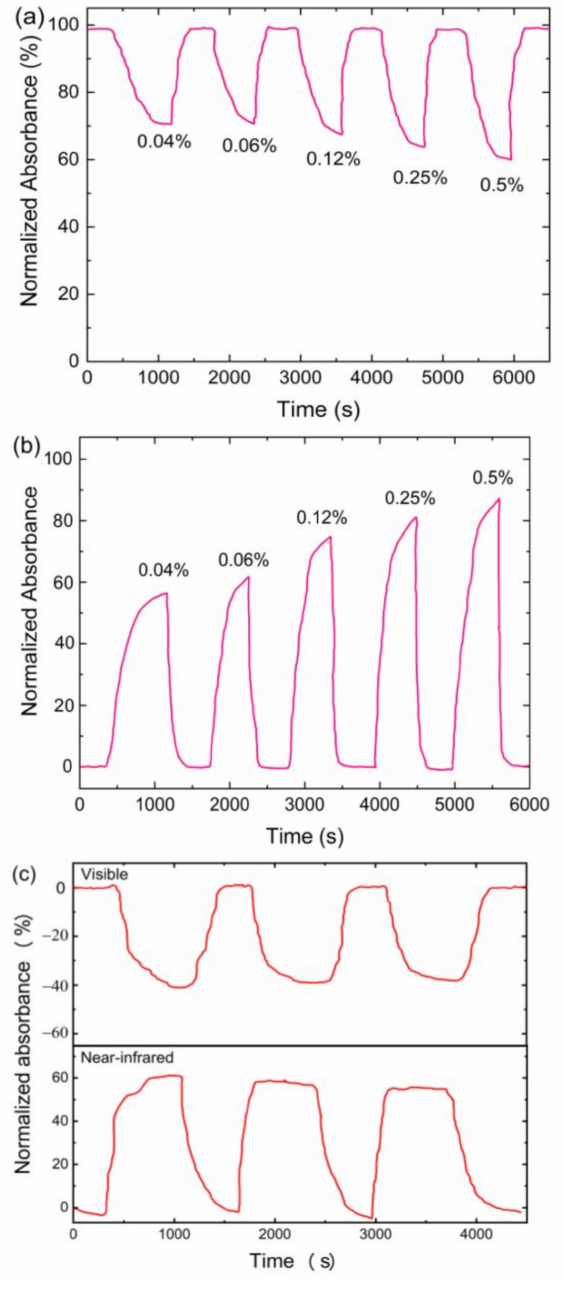
Figure 7. Dynamic response of the GO-coated microfiber sensor at ( a ) visible wavelength (500–700 nm); ( b ) near-infrared wavelength (700–900 nm) under varying NH 3 gas concentrations; ( c ) repeatability of the GO-coated optical microfiber sensors exposed to 3 cycles of 0.04% NH 3